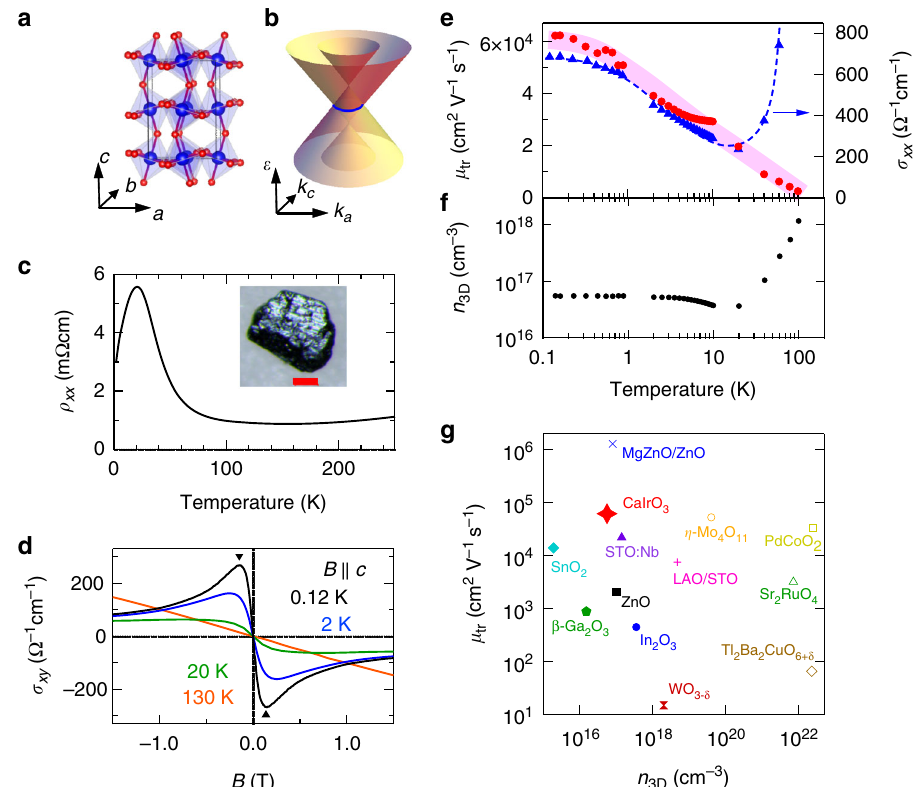
Fig. 1 Unusually large transport mobility in perovskite CaIrO 3 . a The crystal structure and b the sketch of Dirac-like dispersion near the line node (blue line). The primitive vectors a , b , and c are de fi ned in the orthorhombic notation with space group Pbnm . c Temperature dependence of the resistivity. The inset is the photograph of single-crystalline CaIrO 3 . The red bar denotes the length of 100 μ m. d The Hall conductivity σ xy vs. B ( B = μ 0 H , with μ 0 the vacuum permittivity) at various temperatures. The reciprocal fi eld of peak or dip as indicated by triangles corresponds to the averaged transport mobility μ tr . e , f show the μ tr and density ( n 3D ) of highest mobility carrier as a function of temperature. The temperature dependence of electrical conductivity σ xx is also shown. g The μ tr of typical high-mobility oxide semiconductors and metals 21, 32 – 40 as well as the heterostructure of (Mg,Zn)O/ZnO 41 and LAO(LaAlO 3 )/ STO(SrTiO 3 ) 42 . The carrier densities of heterostructures are derived by assuming the effective channel thickness of 10